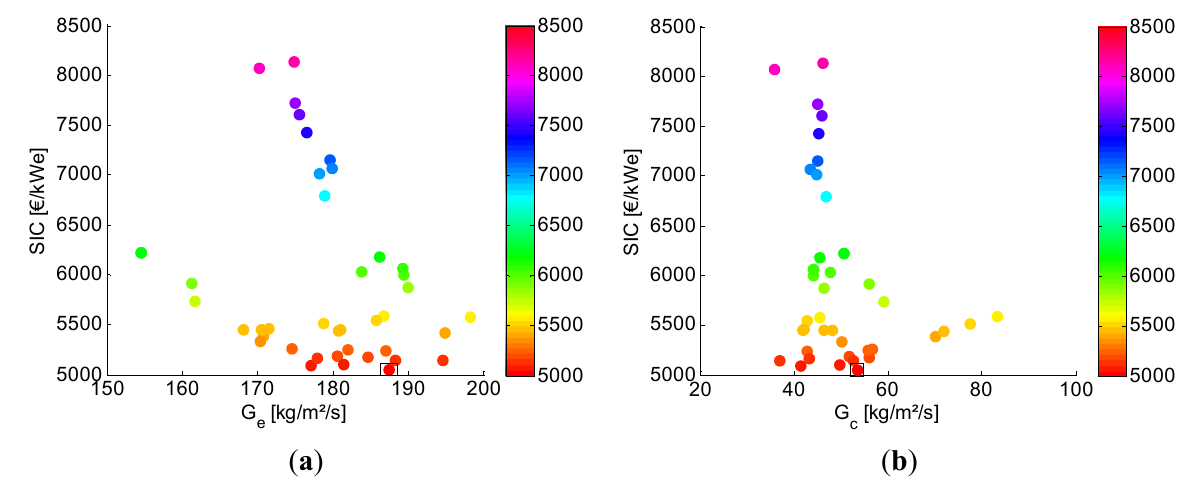
Figure 12. ( a ) (cid:1833)